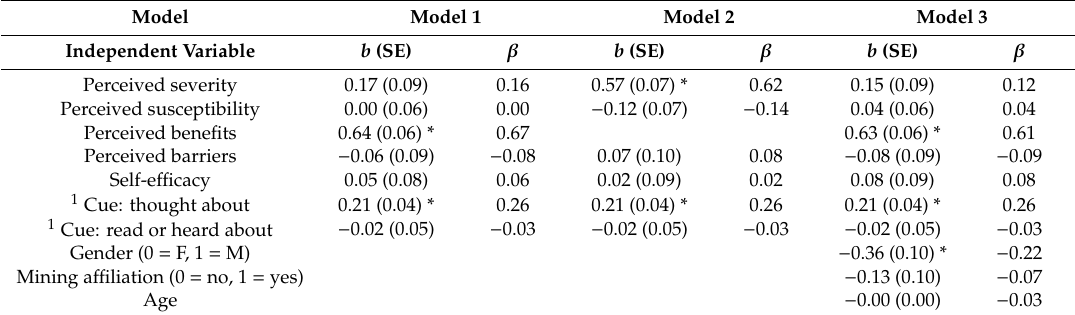
Table 4. Associations between HBM variables and behavioral intentions (dependent variable), n =